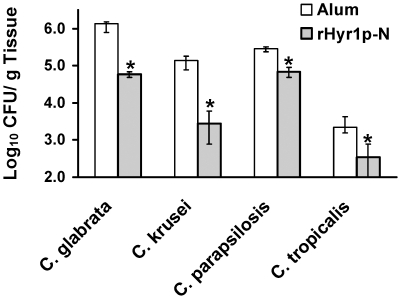
rHyr1p-N vaccine reduces tissue fungal burden in BALB/c mice infected with non-albicans species of Candida.BALB/c mice (n = 10 per group) were vaccinated with alum or alum plus rHyr1p-N (30 µg) and boosted three weeks later. Two weeks after the boost, mice were challenged via the tail vein with C. glabrata (3.2×107), C. krusei (3.4×107), C. parapsilosis (9.6×106), or C. tropicalis (3.2×106). Kidney fungal burden was determined on day 3 post infection. The y axis reflects the lower limit of detection of the assay. * P<0.001 versus adjuvant control by the Mann-Whitney U test.